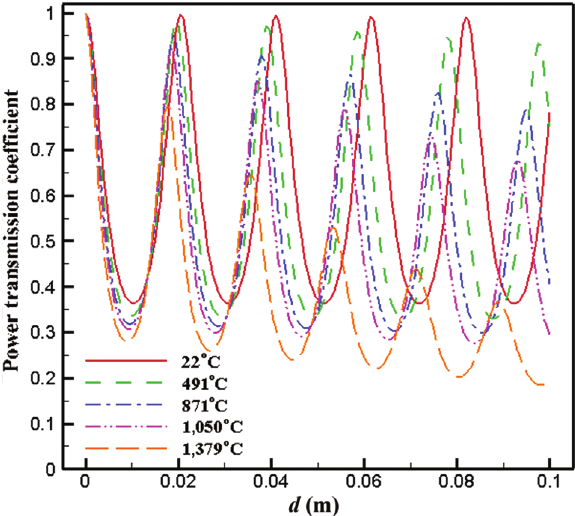
Figure 2: Temperature dependence of PTC of the Al 2 O 3 slab as the thickness varies from 0 to 0.1 m at 2,450 MHz: 22°C, 491°C, 871°C, 1,050°C, 1,379°C.